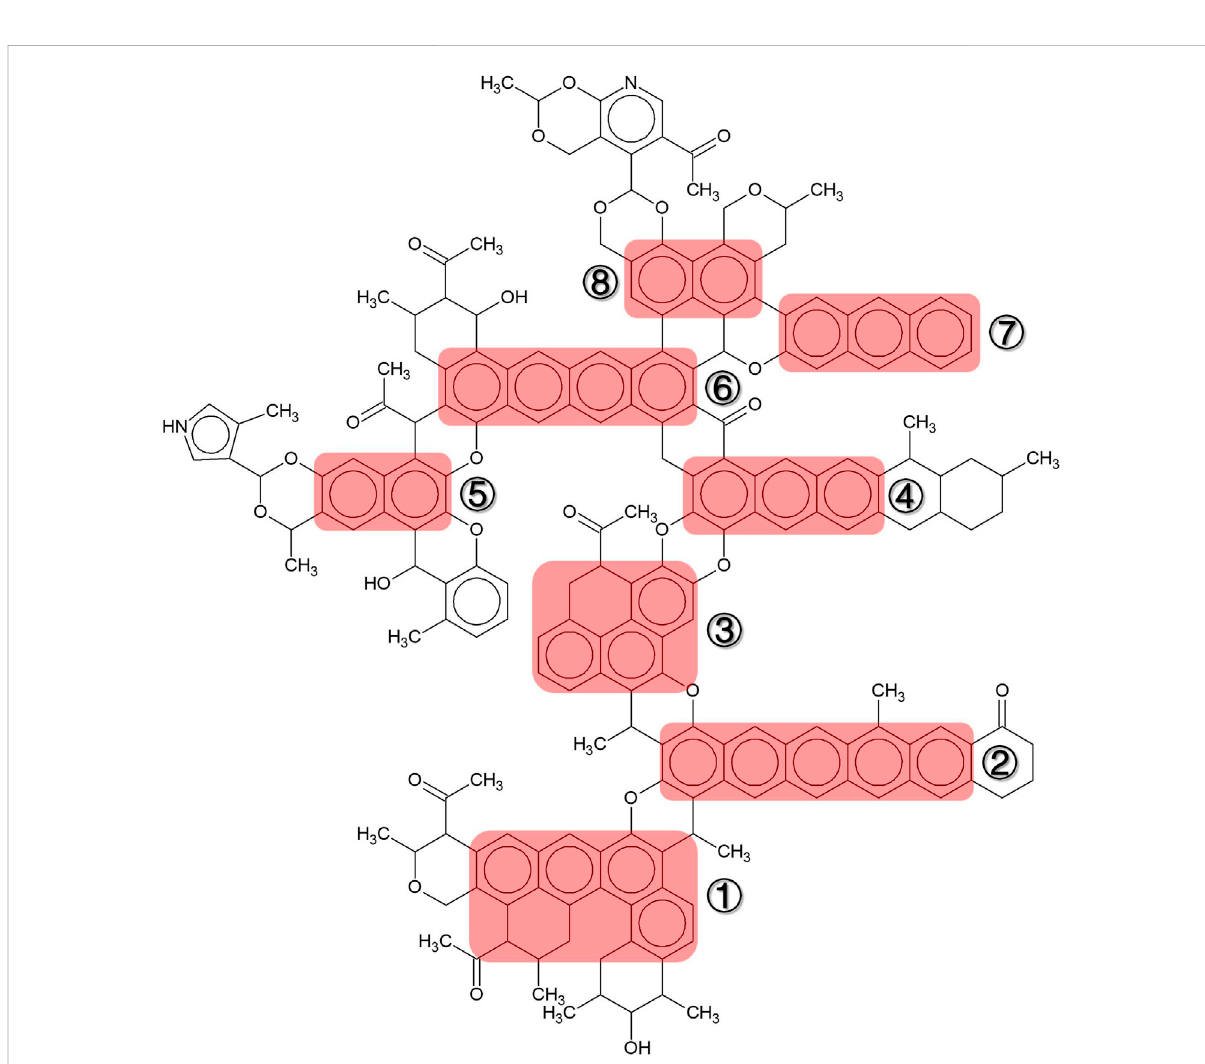
Selected fused aromatic chains in the plane model of the primary structure coal conformation. 1 — Benz(a)anthracene; 2 — pentacene; 3 — phenanthrene; 4 — anthracene A; 5 — naphthalene A; 6 — naphthacene; 7 — anthracene B; 8 — naphthalene